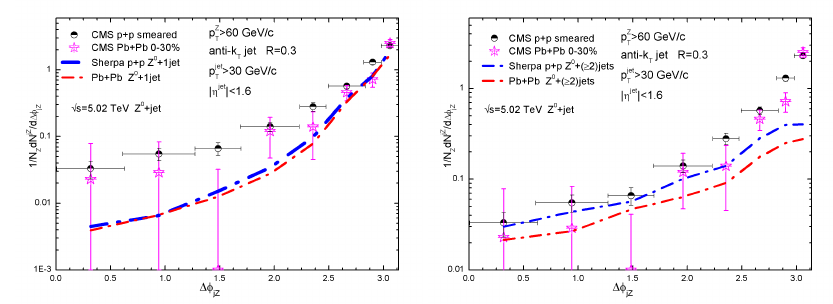
Figure 8. Azimuthal angle distributions of Z 0 tagged jet production when considering the processes of Z 0 plus only one jet (left), and Z 0 plus more than one jet (right) both in p + p and central Pb + Pb collisions at √ s NN = 5 . 02